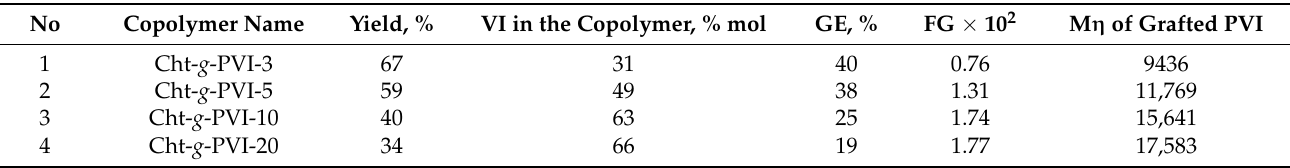
Table 2. Graft copolymer